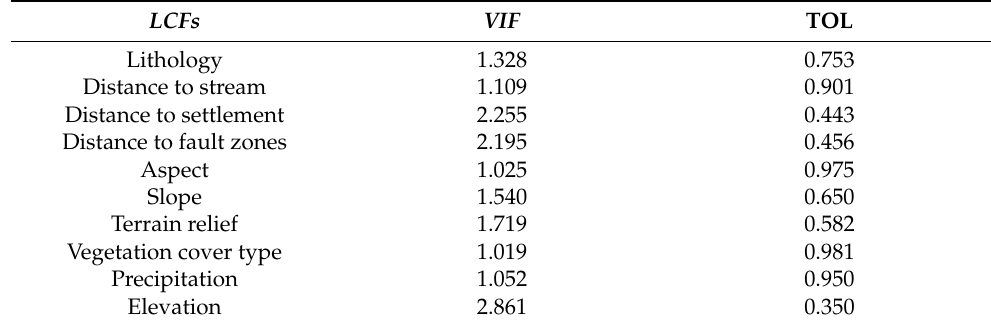
Table 1. Multicollinearity test of LCFs .